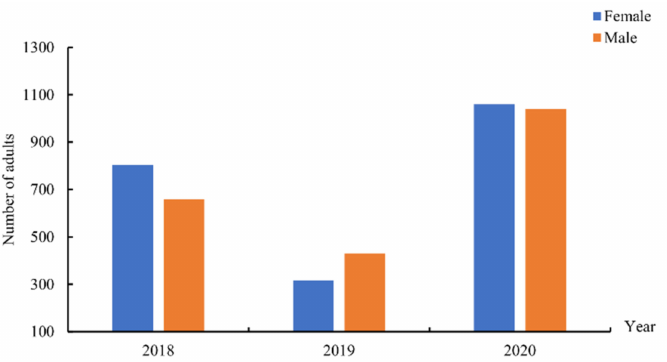
Figure 6. Number of male and female M. saltuarius adults collected from traps in different